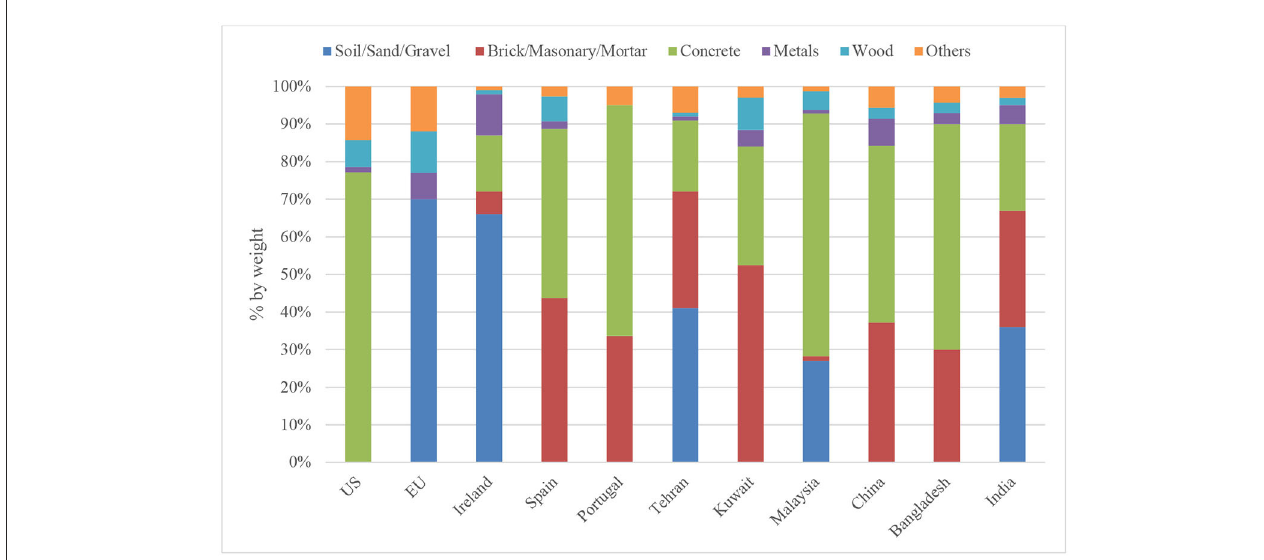
FIGURE2 Typical composition of C&D waste in India and worldwide.